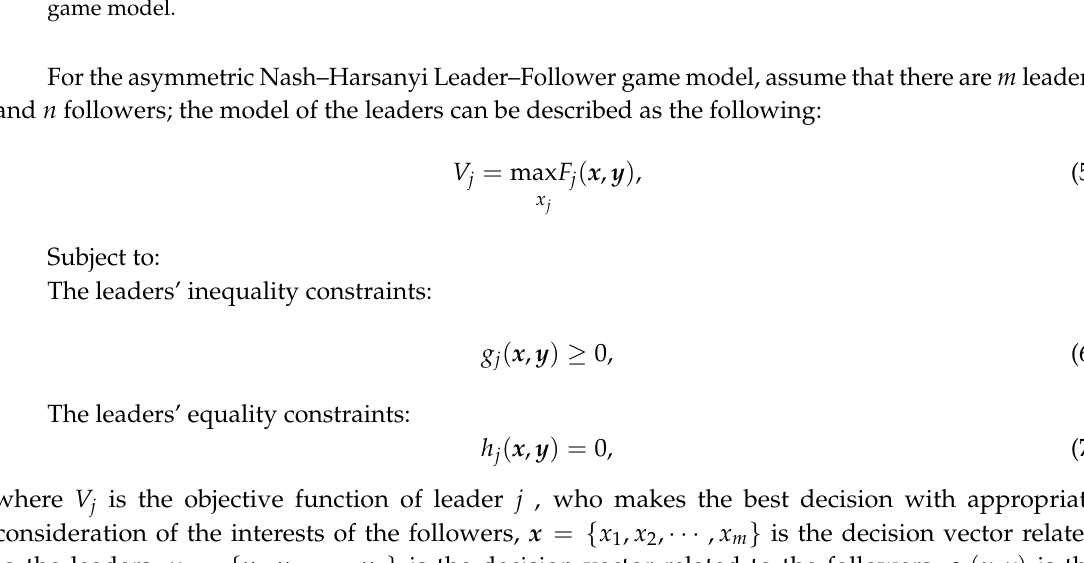
Figure 2. A two ‐ level hierarchical structure of the asymmetric Nash–Harsanyi Leader–Follower game model.